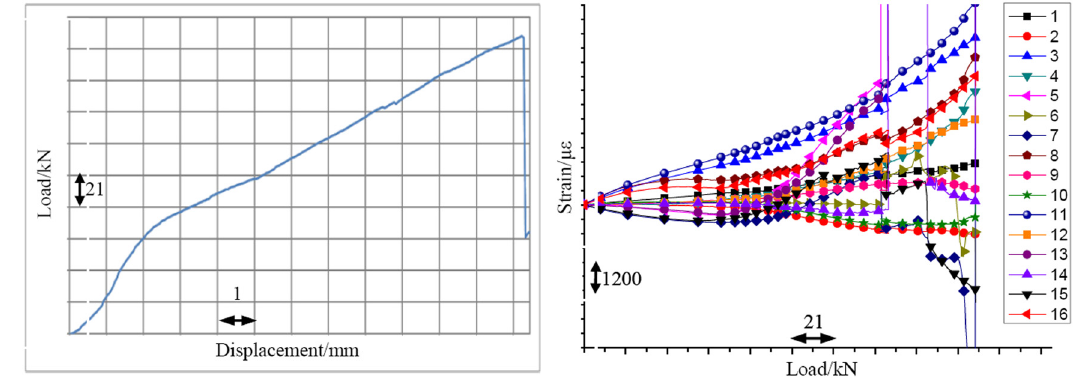
Figure 3: a1 - type test curve.